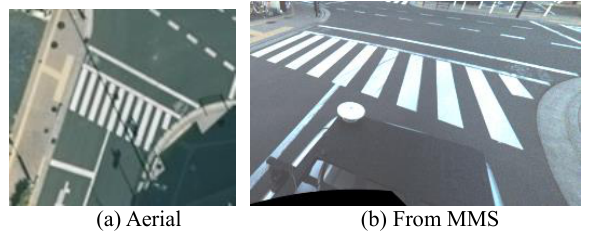
Figure 9. Processing area photos